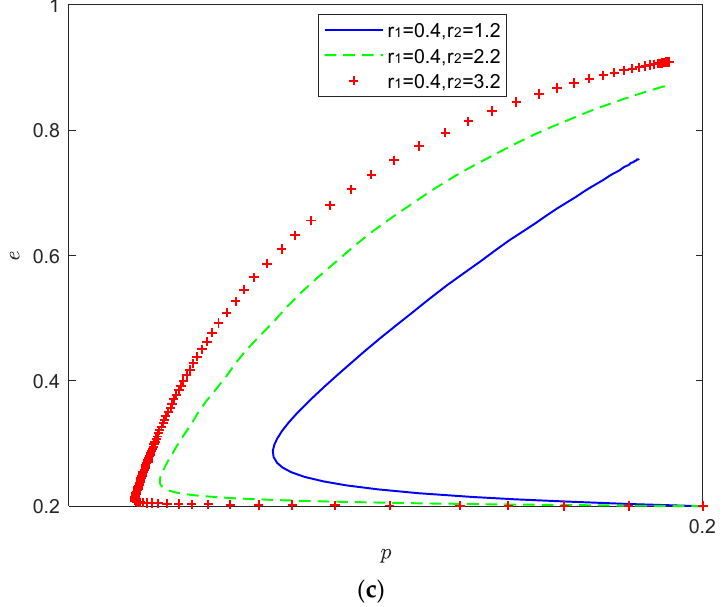
Figure 6. Evolution of game strategy in (optimistic, pessimistic) state. ( a ) Scenario 1, ( b ) Scenario 2, ( c ) Scenario 3.